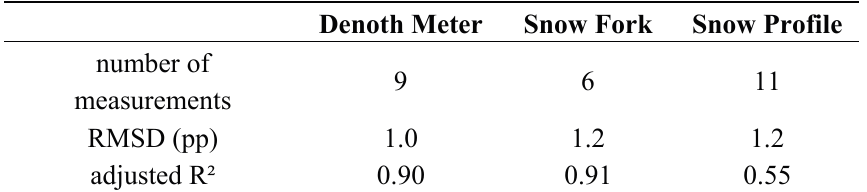
Table 2. Difference between the GPS-derived LWC and reference measurements (Denoth meter, Snow Fork and snow profile estimates). The absolute mean difference and the adjusted correlation coefficient are